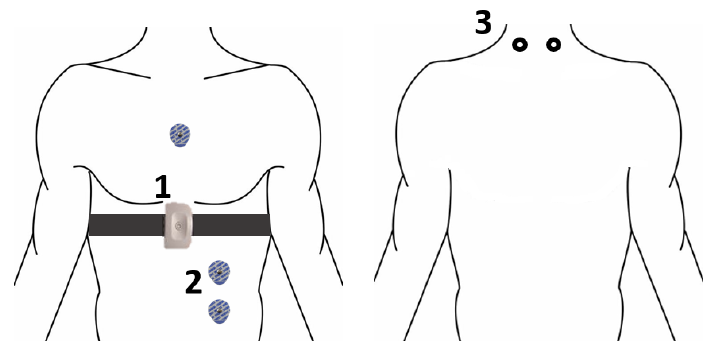
Figure 1. RespiBAN Professional’s placement of electrodes. 1. RespiBAN Professional with temperature, EDA, and control module. 2. Three ECG electrodes. 3. Two EMG electrodes on the back where the shoulder meets the neck. Adapted from [19].